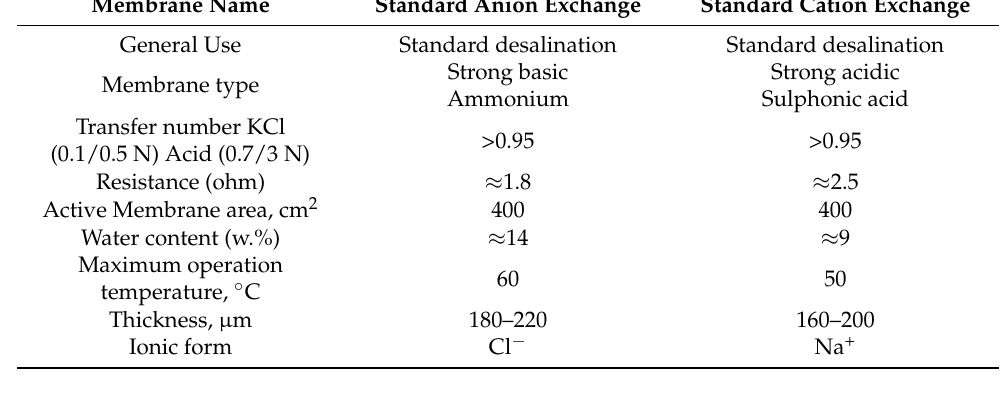
Table 2. Characteristics of anion and cation exchange membranes.